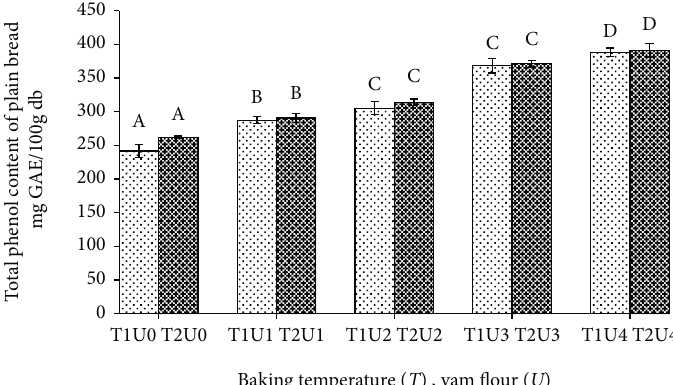
Figure 2: Total phenol content of plain bread with di ff erent baking temperature and yam fl our addition. Note: T1: baking temperature 170 ° C; T2: baking temperature 180 ° C; U0: yam fl our 0%; U1: yam fl our 10%; U2: yam fl our 15%; U3: yam fl our 20%; U4: yam fl our 30%. The letter above the bar graph beside the same number shows that it is not di ff erent based on the DNMRT statistical test at the level of con fi dence